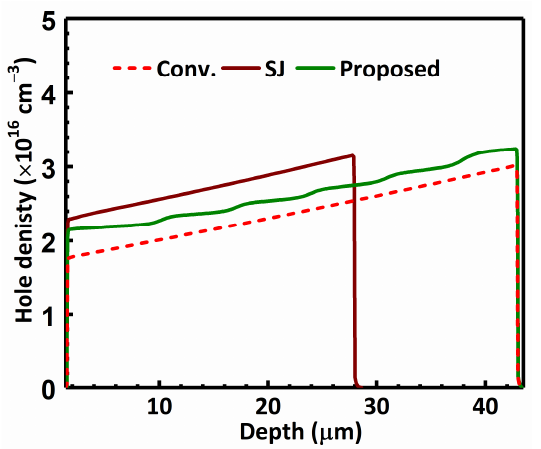
Figure 8. Hole density along the depth of the studied MOSFETs at I D = −100 A/cm 2 .